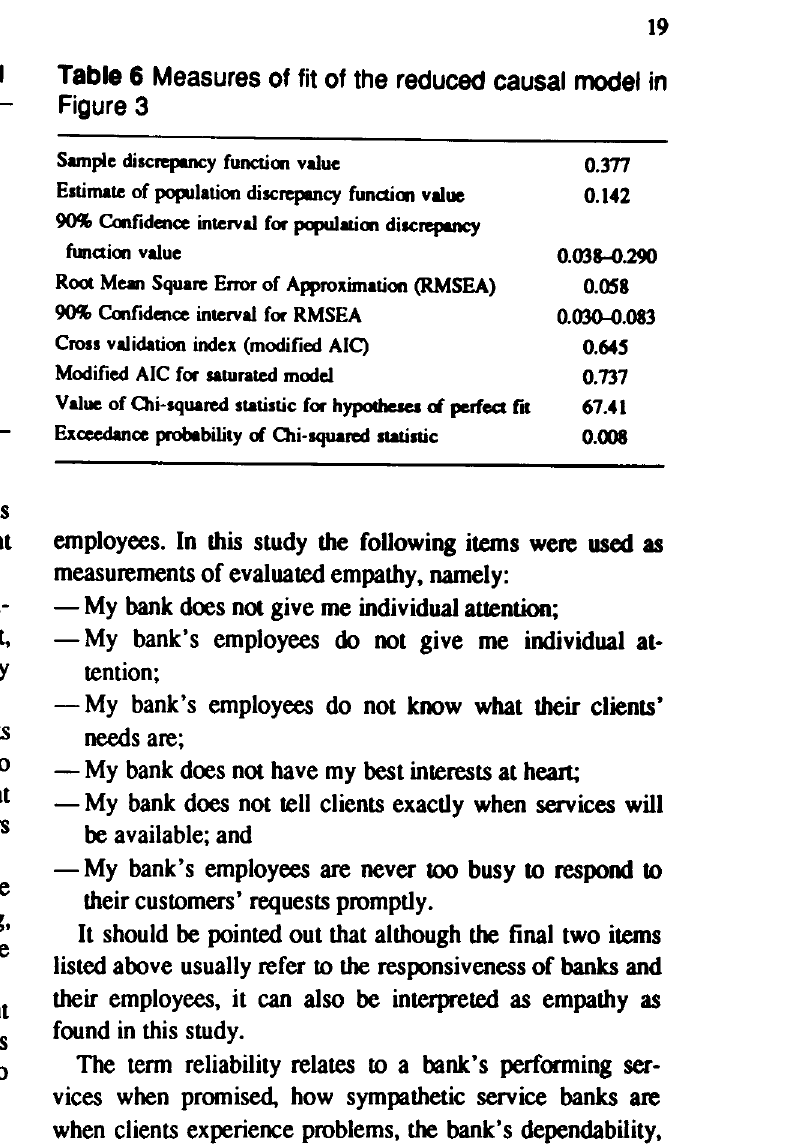
Table s Measures of fit of the causal model in Figure 1